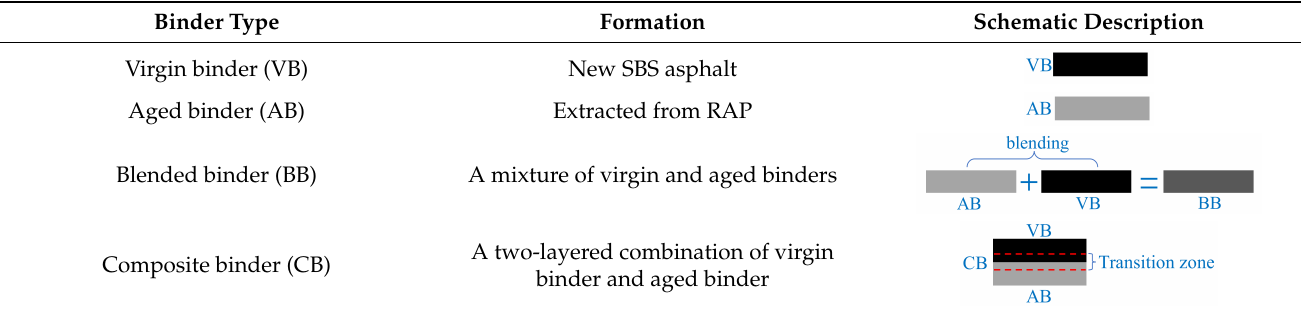
Table 2. Various formations of binders considered in the study.